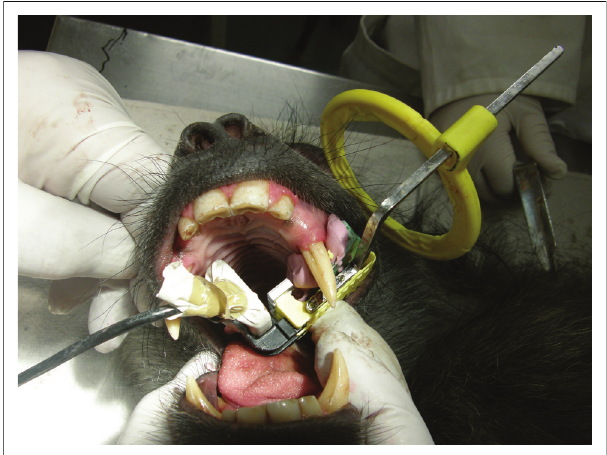
FIGURE 3: An image of the positioning of the apparatus in the mouth of the baboon before an image was acquired.